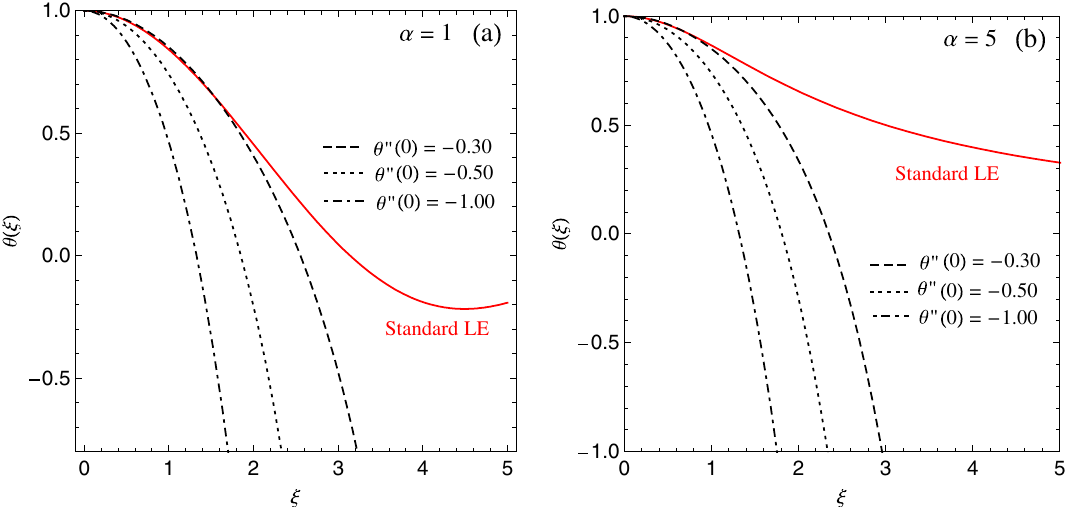
1 and ( b ) α 5 , with = =